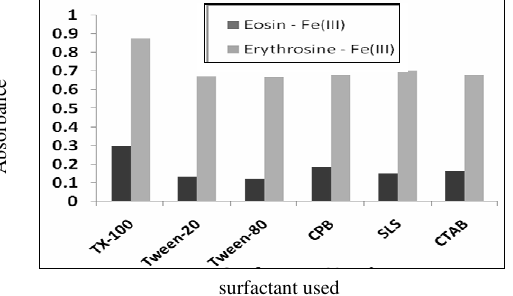
Figure 3. Effect of different surfactants on absorbance of eosin - Fe(III) and Erythrosin - Fe(III)